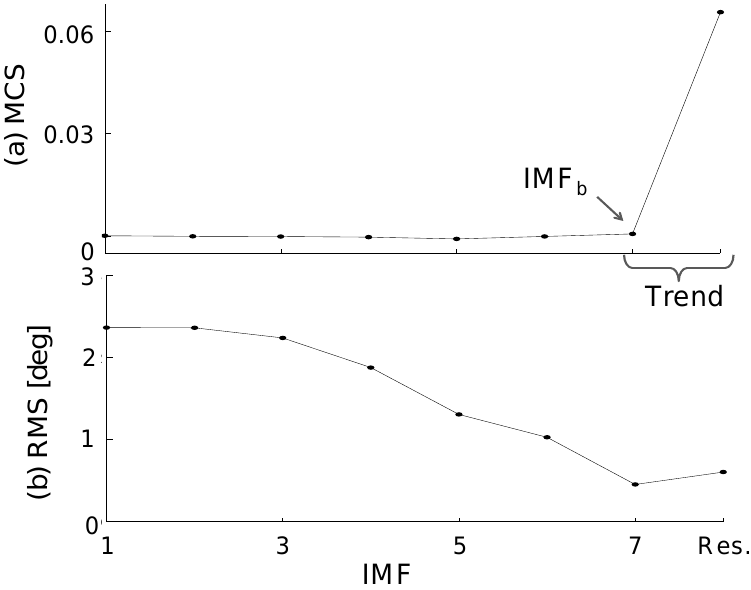
Figure 4. Representative results obtained for one randomly selected trial showing the variations in the retained criterion (Equation (2)) used to select the number of IMFs used in the trend estimate ( a ). In this trial, IMF number seven was selected as the best one for trend estimation ( b ).